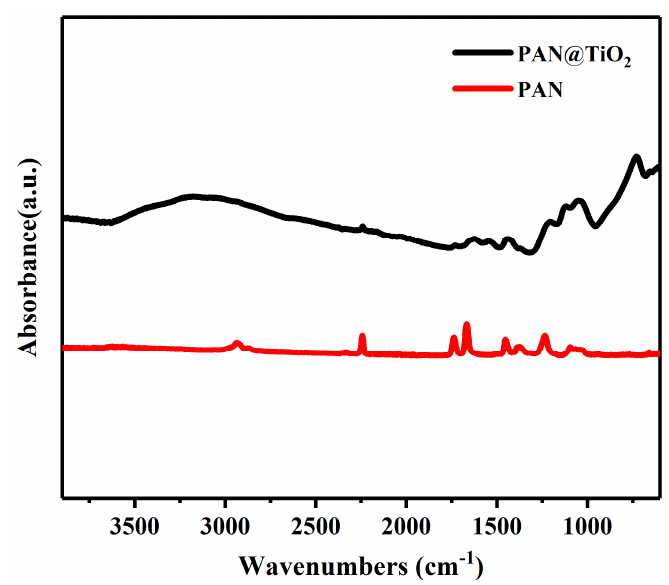
Figure 4. Fourier transform infrared spectrometer (FTIR) spectra of PAN and PAN@TiO 2 nanofibers in the range of 4000 cm -1 to 500 cm -1 .